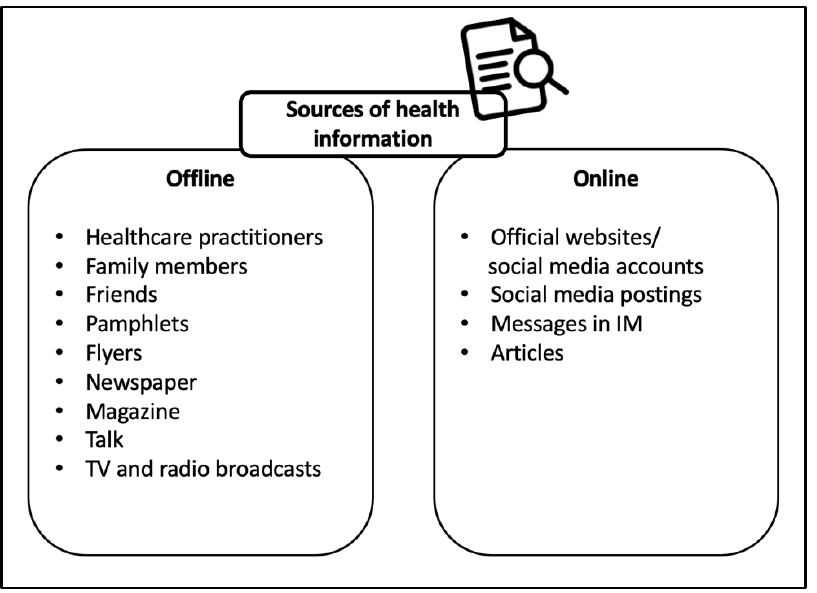
Figure 1. The sources of health-related information.